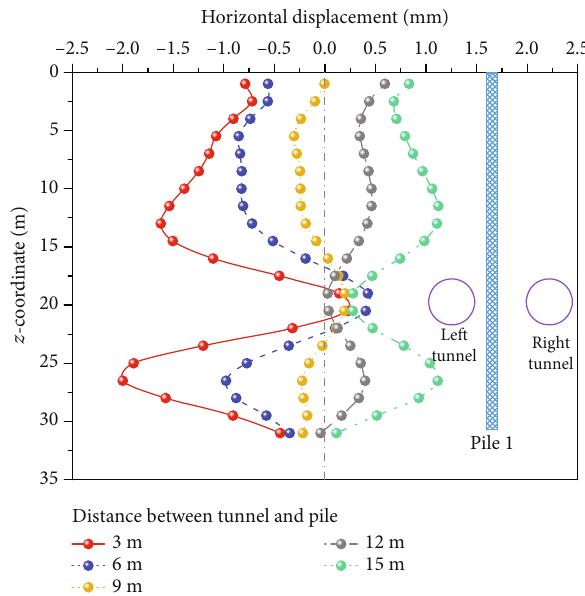
Figure 13: Axial pile stresses on completion of twin tunneling.